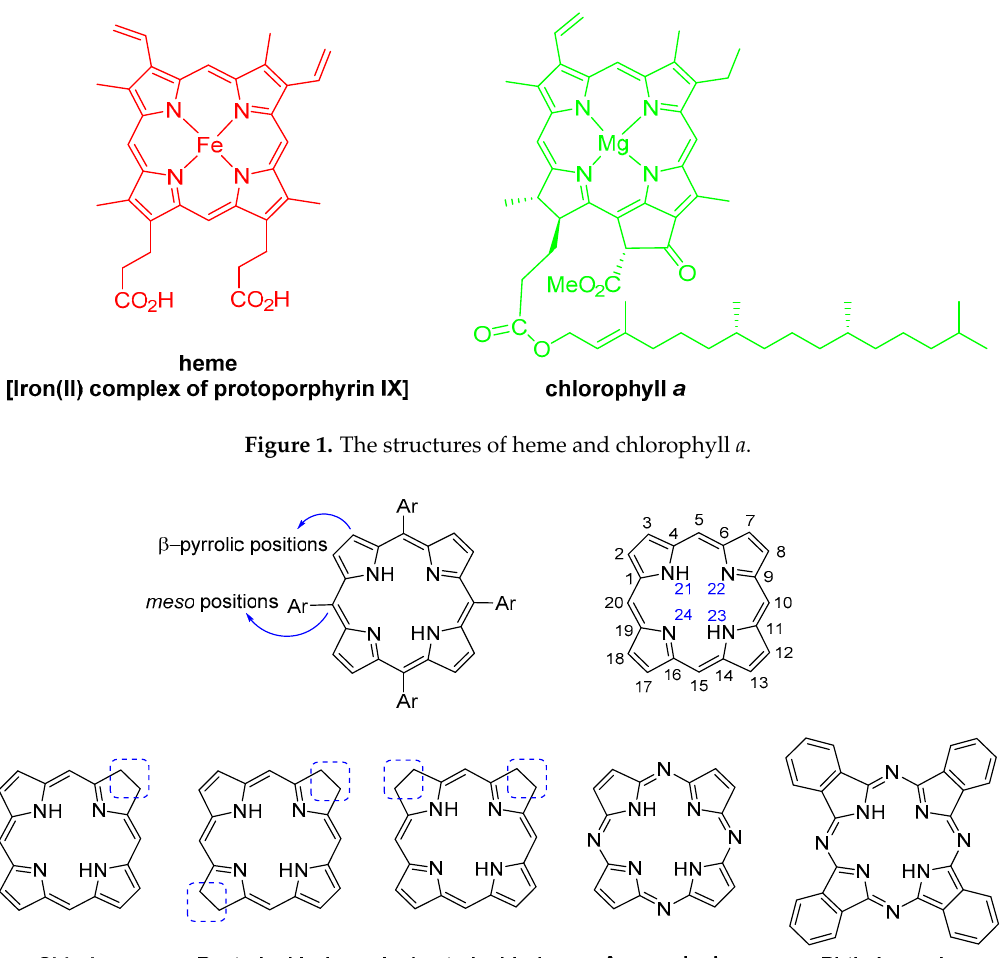
Figure 1. The structures of heme and chlorophyll a .